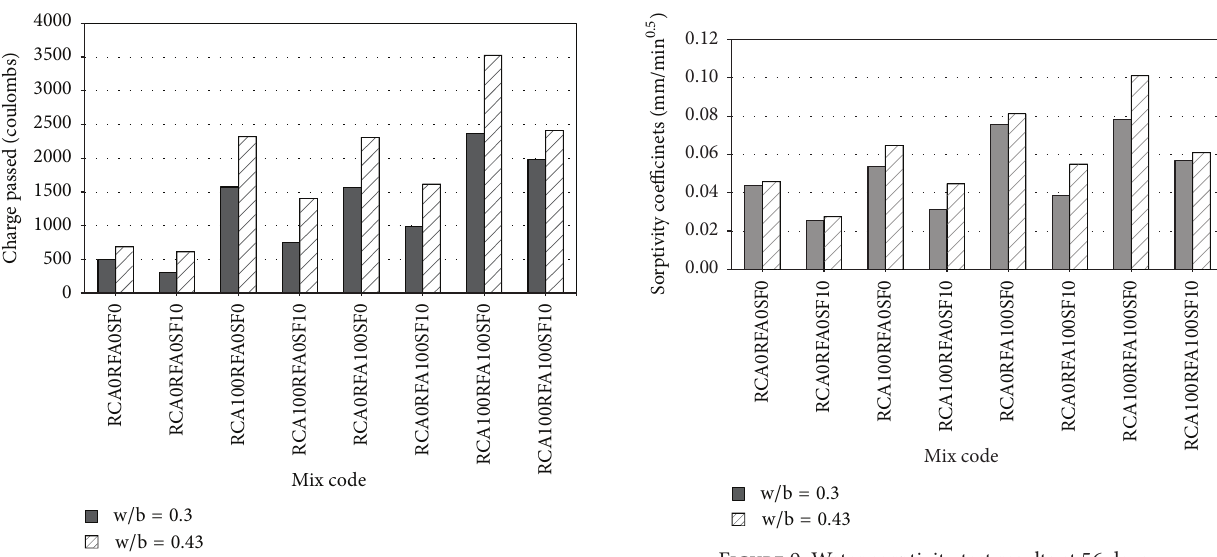
determined from weight gain of the specimen with time of exposure of the lower surface to water [33]. The 56-day sorptivity coefficients of SCC for different aggregate types, w/b ratios, and mineral admixtures are given in Table 5 and graphically shown in Figure 9. The test results demon- strated that, when RAs were used, the sorptivity coefficients increased. Generally, the sorptivity test measures the rate at which water is drawn into the pores of concrete. For this, it is strongly related to the absorption capability of